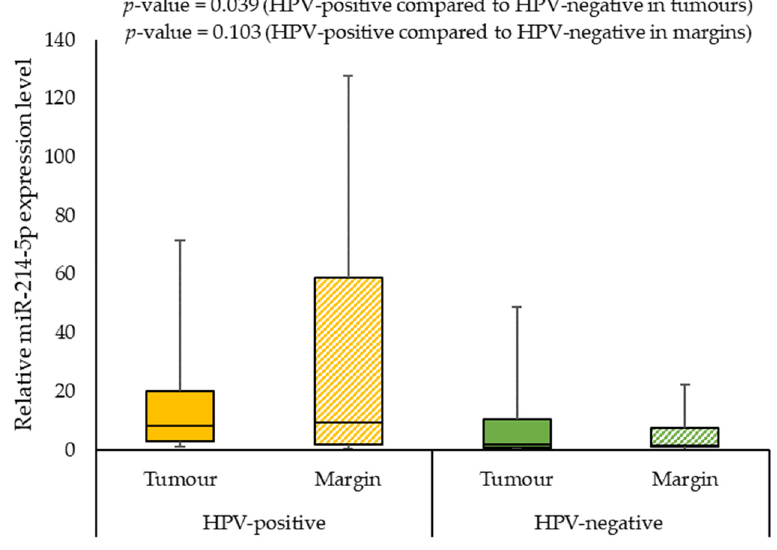
Figure 7. The relative expression level of miR-214-5p in HPV-positive compared to HPV-negative patients.